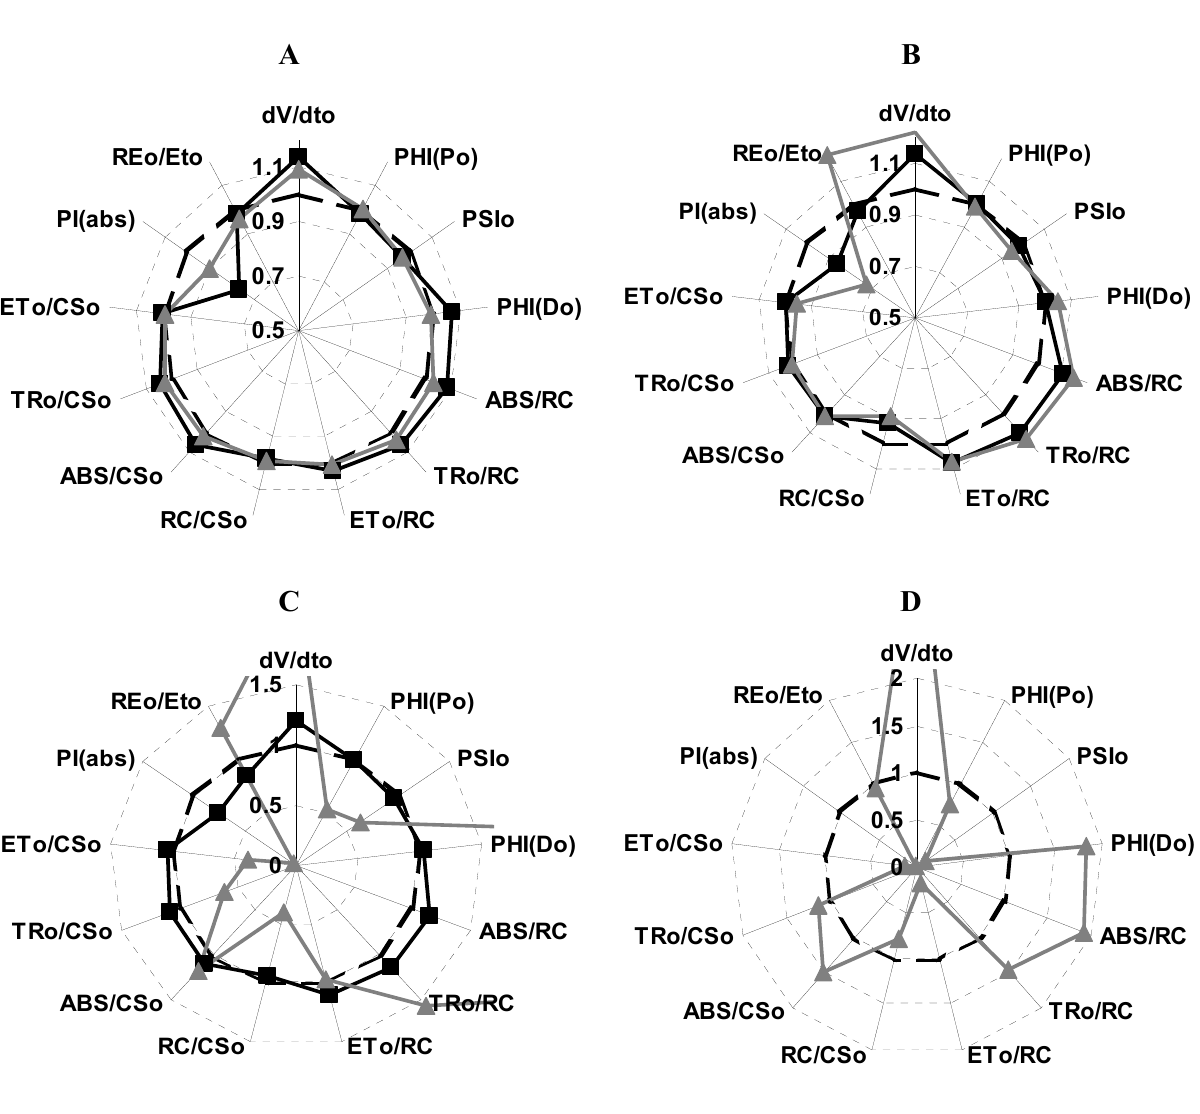
Figure 5. Effect of 1 at 50 (  ) and 100 µg/mL (  ) on different calculated parameters from OJIP curves measured on P. ixocarapa plants treated after 24 h (Panel A), 48 h (Panel B) and 72 h (Panel C), and 50 µM DCMU (Panel D) after 72 h of treatment.